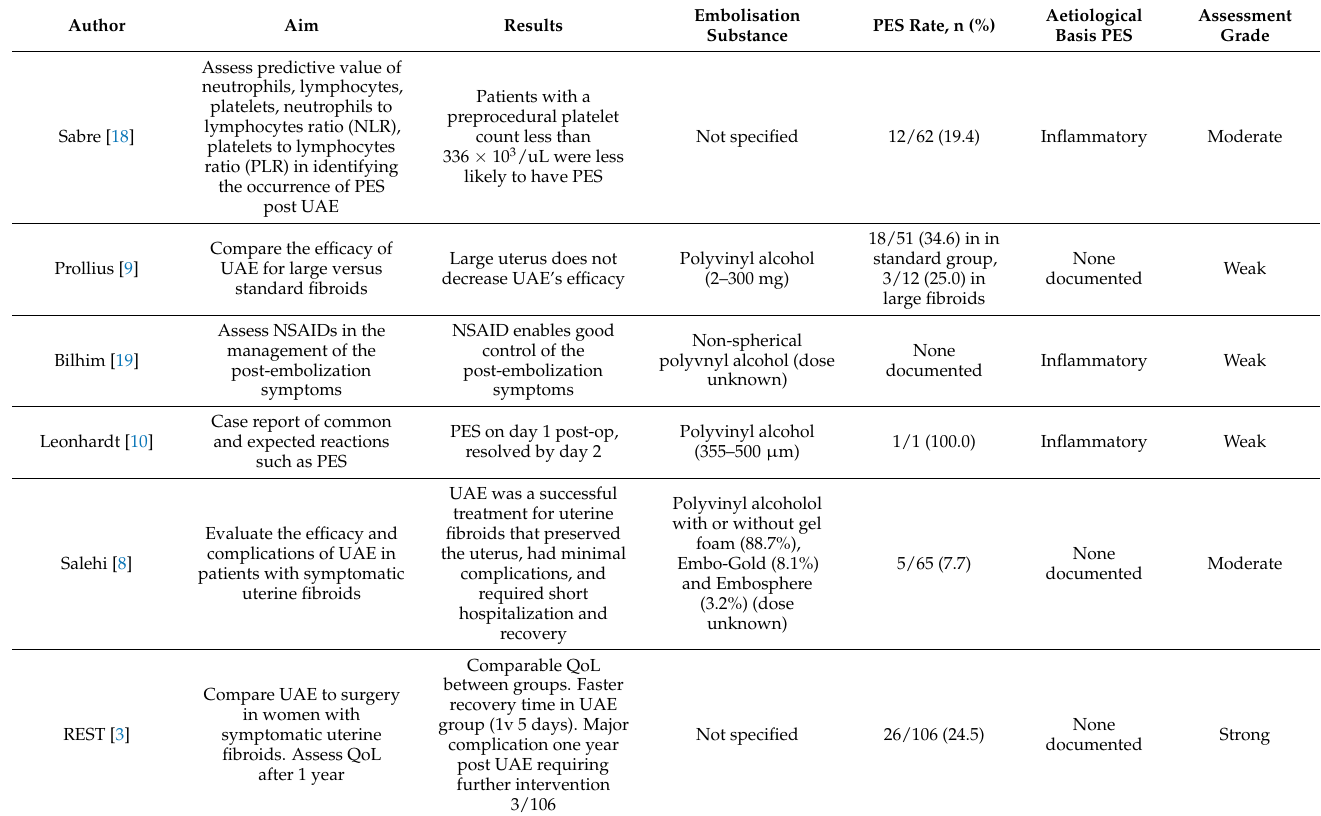
Table 2. Aims, results, incidence and aetiology of PES of included